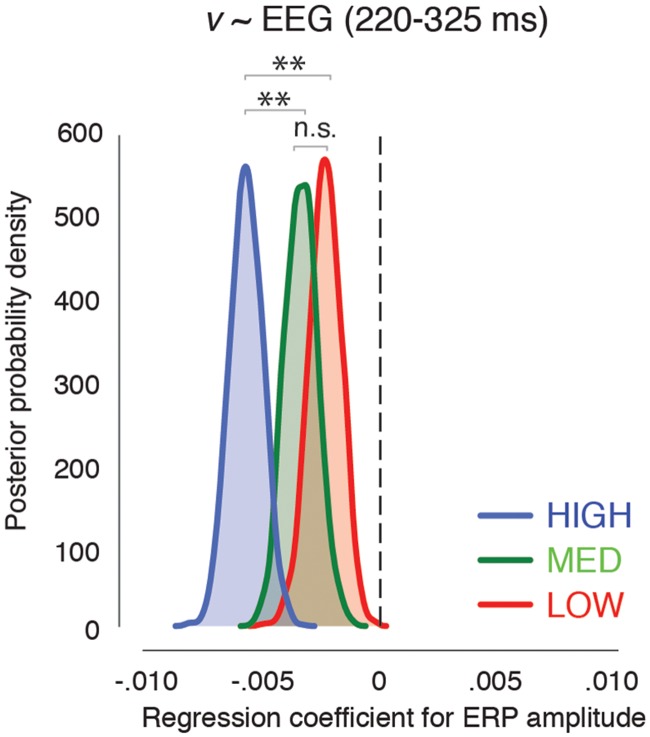
HDDM regression results.Posterior probabilities of the regression weight for drift rate (v) on the single-trial ERP amplitude averaged between 220–325 ms after stimulus onset for LOW, MED and HIGH complexity.